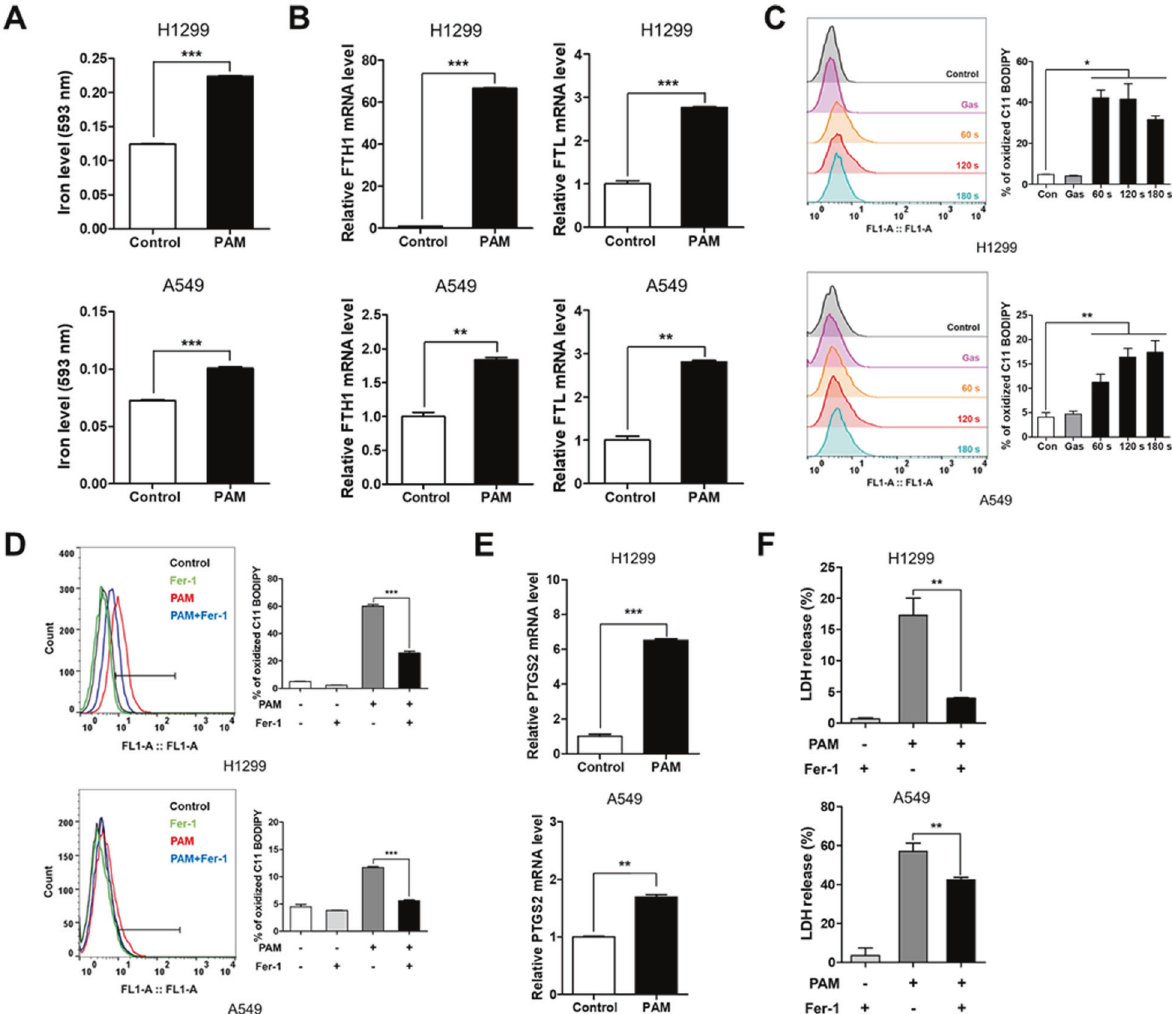
Fig. 3 Plasma-activated medium induces ferroptosis in human lung cancer cells. The plasma exposure conditions were 1.9 standard liter per minute (SLM), 7 W input power and three exposure times (60, 120, and 180 s). A The expression levels of labile iron were measured using iron assay kit. Indicated cells were treated with PAM (180 s) for 24 h. B mRNA expression of FTH1 and FTL was measured by qRT-PCR. C PAM- induced lipid ROS levels as assessed by fl ow cytometry using BODIPY 581/591 C11 dye. H1299 and A549 cells were treated with PAM (180 s) for 2 h. D Lipid ROS levels were detected using BODIPY 581/591 C11 dye. The indicated cells were treated PAM (180 s) or 2 μ M ferrostatin-1 for 2 h. E The expression of PTGS2, the representative ferroptosis marker, was measured by qRT-PCR. F H1299 and A549 cells were treated